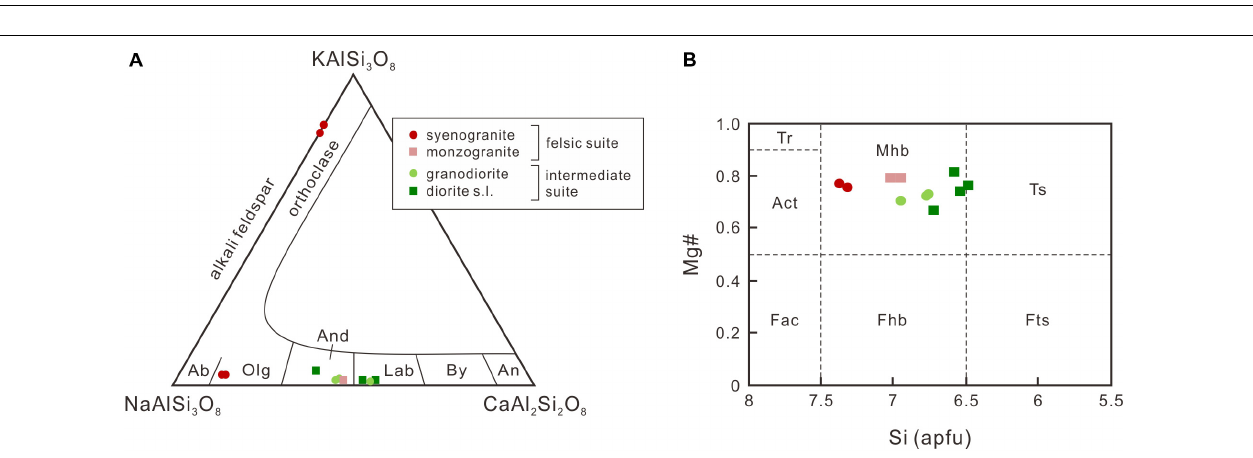
FIGURE 5 | Diagrams illustrating zircon U-Pb geochronologic results for two selected samples. (A) Wetherill concordia diagram and representative zircon CL images for sample I-12 (diorite). (B) 206 Pb*/ 238 U age for individual spot analysis for sample I-12 (diorite). (C) Wetherill concordia diagram and representative zircon CL images for sample E-15 (monzogranite). (D) 206 Pb*/ 238 U age for individual spot analysis for sample E-15 (monzogranite). Red circles on CL images denote analyzed spots of 20 µ m. The diagrams are generated by IsoplotR (Vermeesch, 2018). Asterisk denotes correction for unradiogenic lead by isochron regression by the Ludwig (1998) algorithm. In frames (B,D) , filled bars denote analyses used for mean age calculation and empty ones do not.